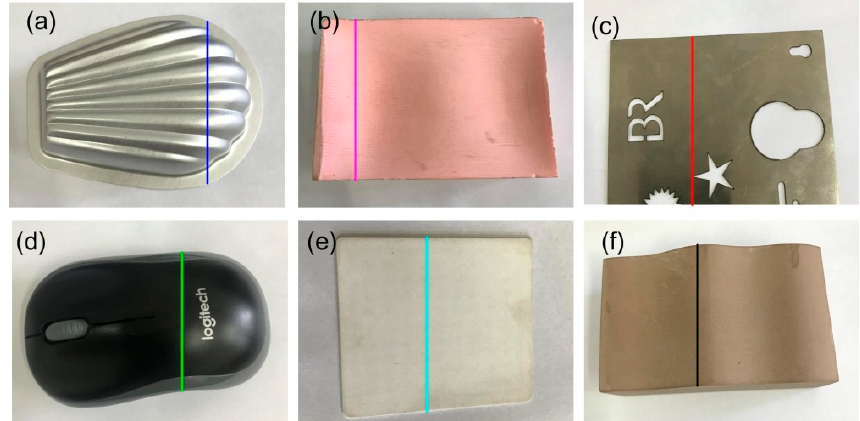
Figure 5. Parts of different optical reflection characters. ( a ) Aluminum stamped part; ( b ) pink freeform resin part; ( c ) stainless steel sheet; ( d ) black plastic part; ( e ) matt ceramic plate; ( f ) brown resin part.